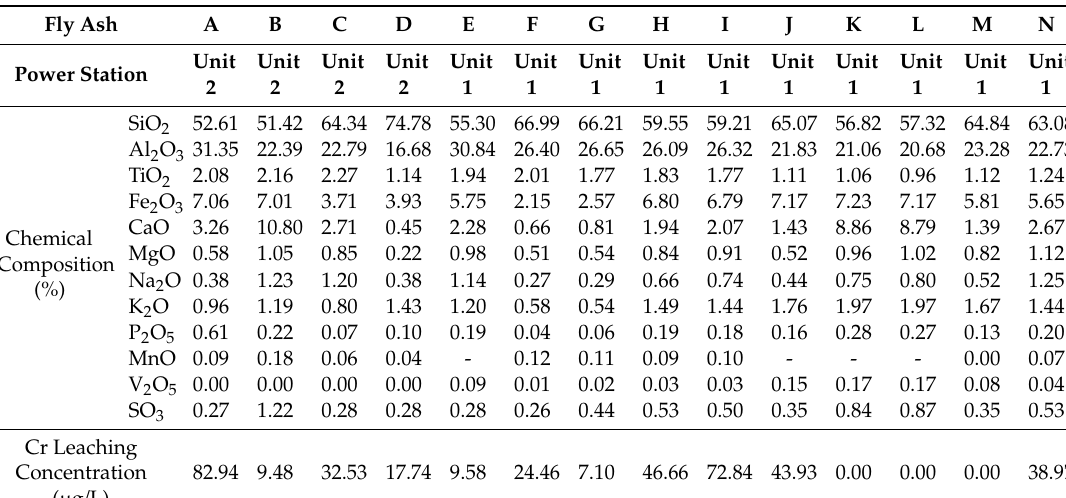
Table 1. Chemical composition of coal fly ash